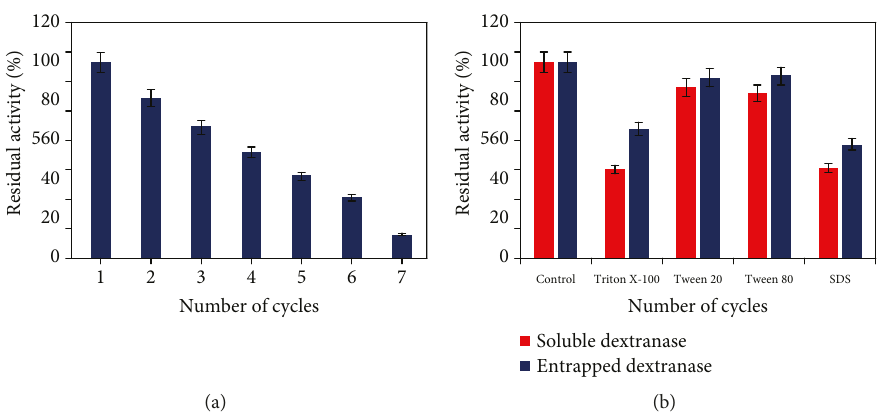
Figure 5: (a) Recycling e ffi ciency of dextranase entrapped in the calcium alginate sphere system under speci fi ed condition. (b) E ff ect of di ff erent surfactants on the activity of soluble as well as entrapped dextranase. All values are shown as mean of three independent experiments ( n = 3